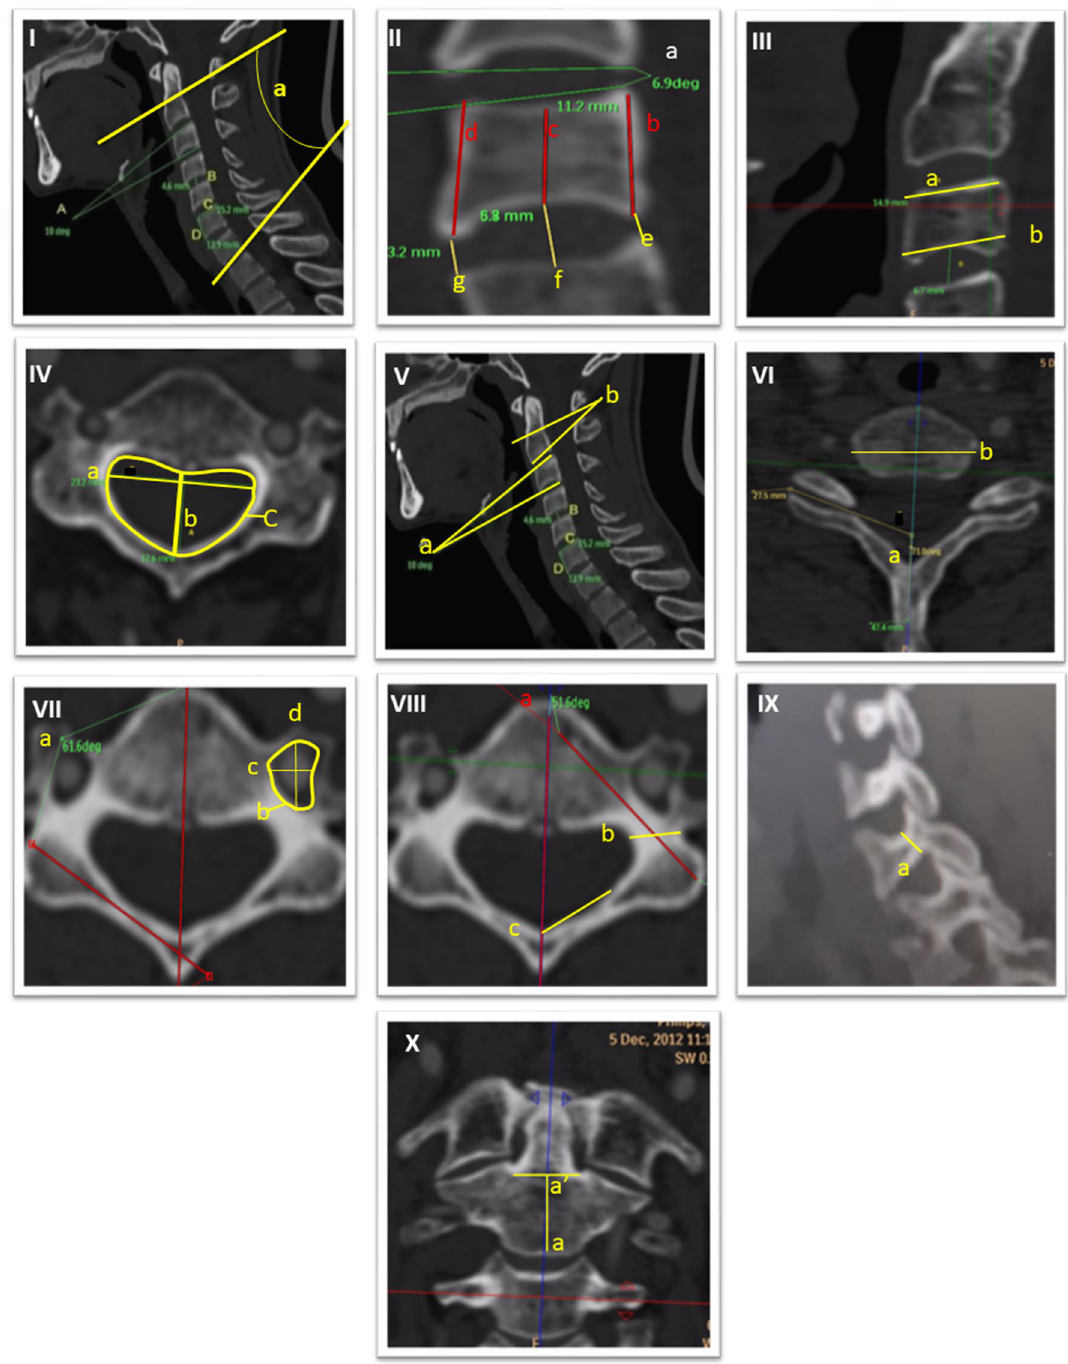
Figure 6. Morphometric measurements. ( I ) Supine cervical lordosis; ( II ) a—sagittal intervertebral disc wedging, b—posterior vertebral body (VB) height, c—middle VB height, d—anterior VB height, e—posterior disc height, f—middle disc height, g—anterior disc height; ( III ) a—superior VB length, b—inferior VB length; ( IV ) a–c—spinal canal width length and area, respectively; ( V ) sagittal VB wedging (a = kyphotic C3, b = lordotic C2); ( VI ) a—transverse facet angle, b—superior VB width; ( VII ) a—transverse laminar angle, b—transverse foramen area, c—transverse foramen width, d-transverse foramen length; ( VIII ) a—transverse pedicle angle, b—pedicle width, c—laminar length; ( IX ) a—pedicle height; ( X ) a–a’—anterior VB height of